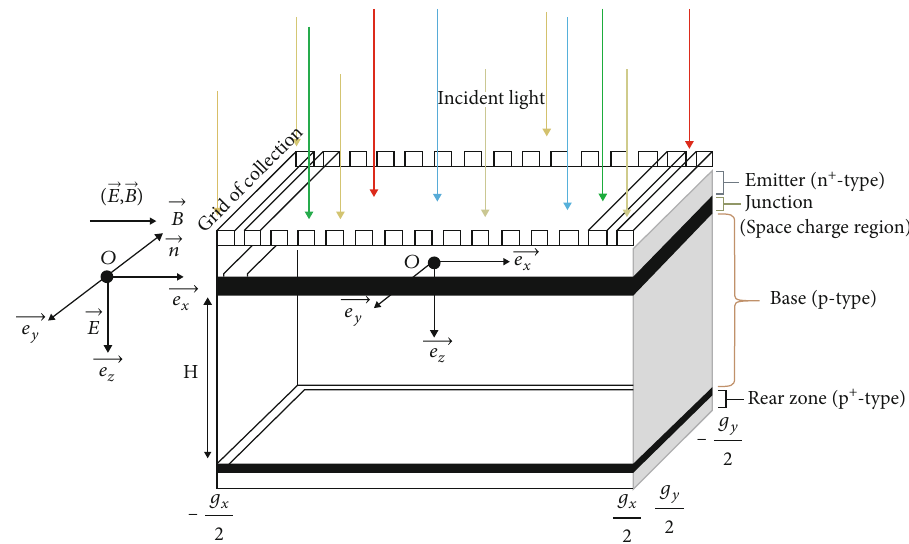
Figure 3: PV cell grain under monochromatic illumination and electromagnetic fi eld.